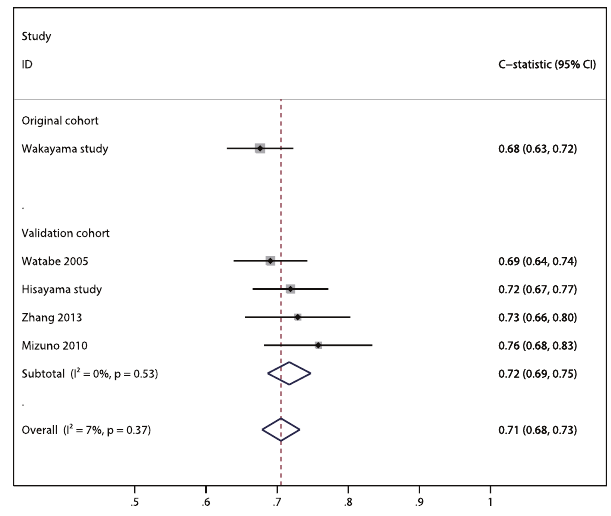
Figure 5. Meta-analysis of c -statistics. The diamonds depict a summary c -statistic and extending 95% confidence interval (CI). Each square and horizontal line indicates the hazard ratio and corresponding 95% CI, respectively, for each study. The size of each square is proportional to the weight of each study in the meta-analysis. Studies are ordered by sample